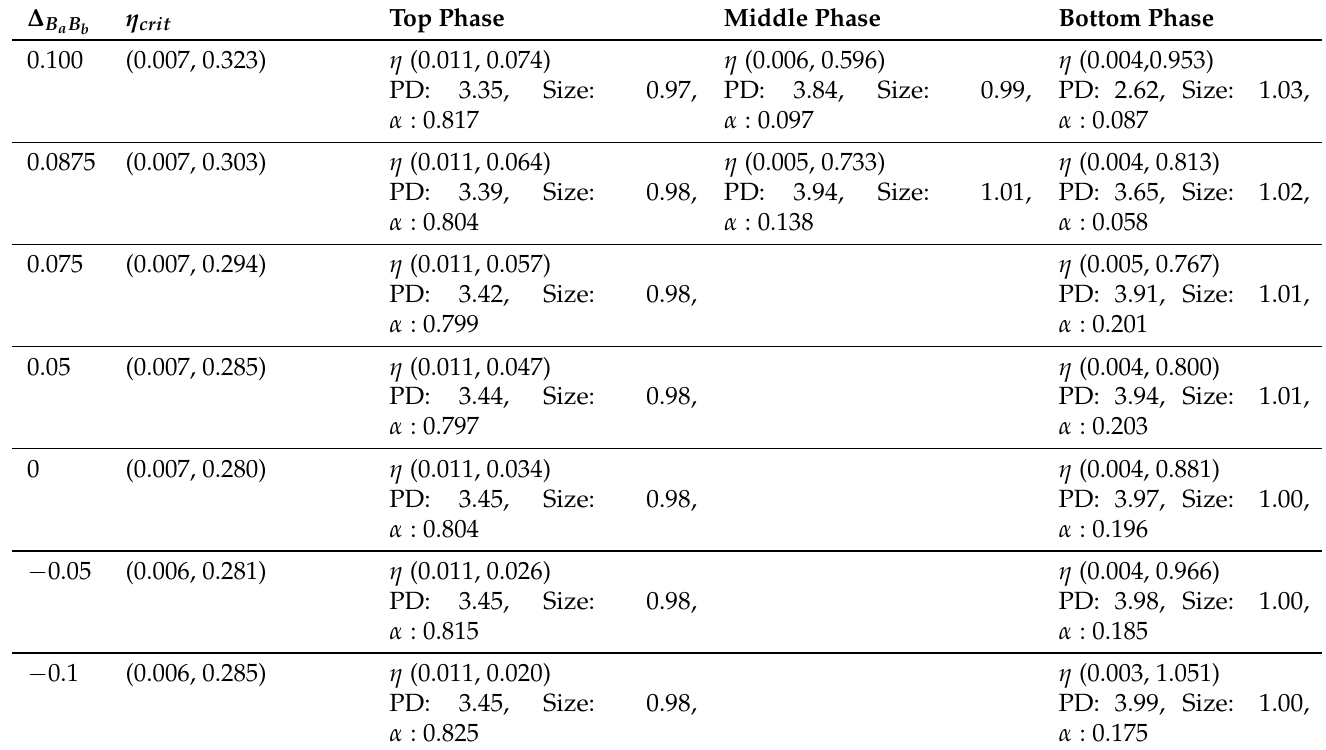
Table 1. Critical points are given for the different binary mixtures, depending on the nonadditivity of component B (see also Figure 3), phase-separated concentrations, and volume fraction α of the different mixtures for a specific parent concentration ( η A the nonadditivity of component B . See also Table 2 for a distribution of component B in each